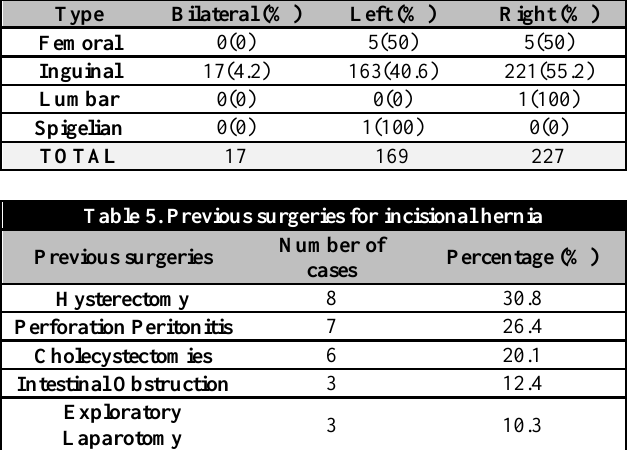
Table 4. Laterality of various types of hernia